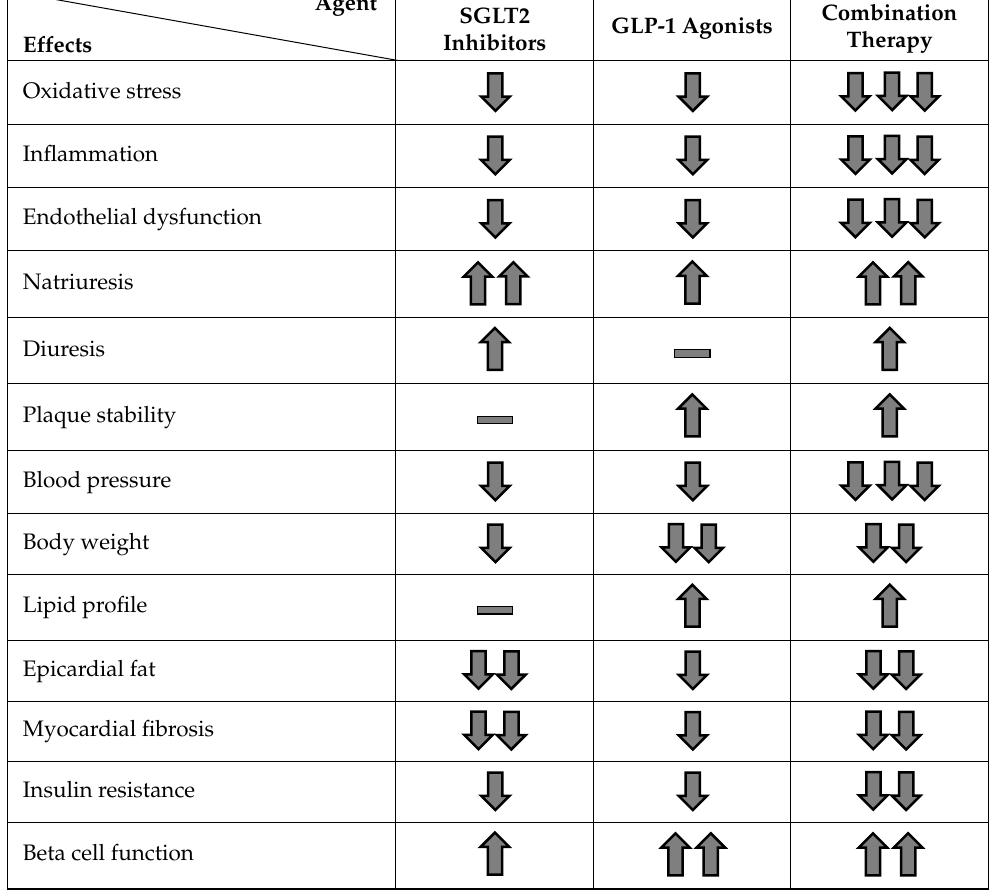
Table 1. Potential biological effects of SGLT1-Is or GLP-1 RAs, alone or in combination therapy.